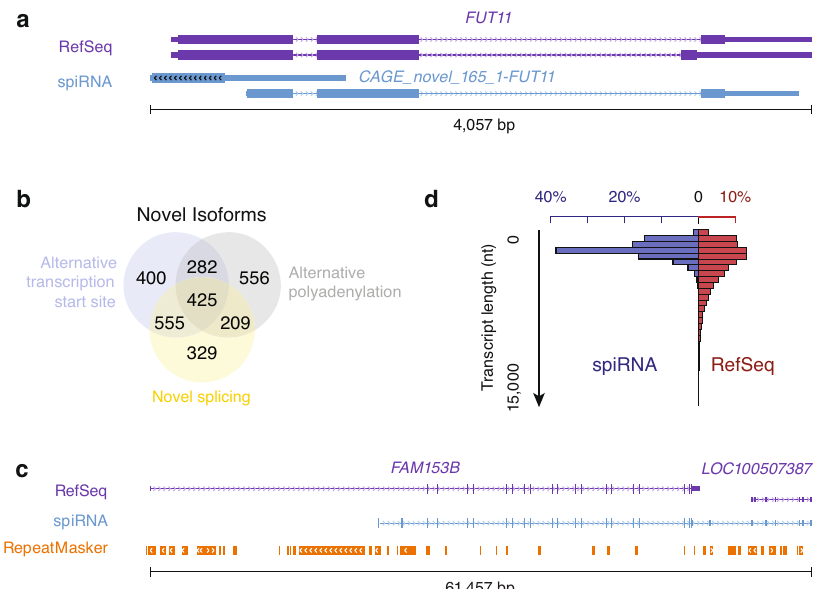
Fig. 5 Diverse transcripts in human sperm. a An example of a novel human spiRNA that is antisense to a known gene locus. From top to bottom, RefSeq and spiRNA. b Venn diagrams showing the contribution of alternative transcription start site, alternative splicing, and alternative polyadenylation to the isoforms that differ from RefSeq. c A spiRNA spans two neighboring genes. From top to bottom, RefSeq, spiRNA and RepeatMasker. d Histogram showing transcript lengths in human. Blue, spiRNAs. Red, RefSeq. Source data of Fig. 5d are provided as a Source Data fi